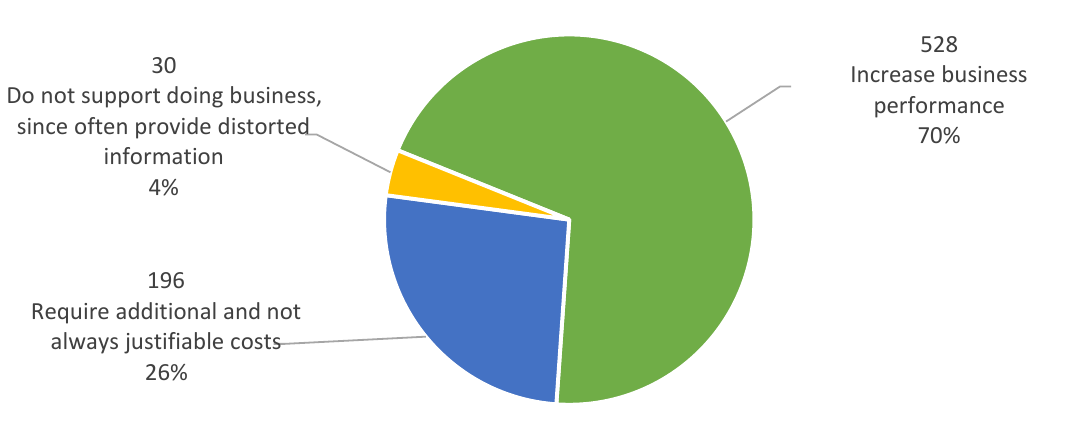
Figure 7. Structural indicators of respondents’ answers on questions that determine the role of Internet platforms in their business performance